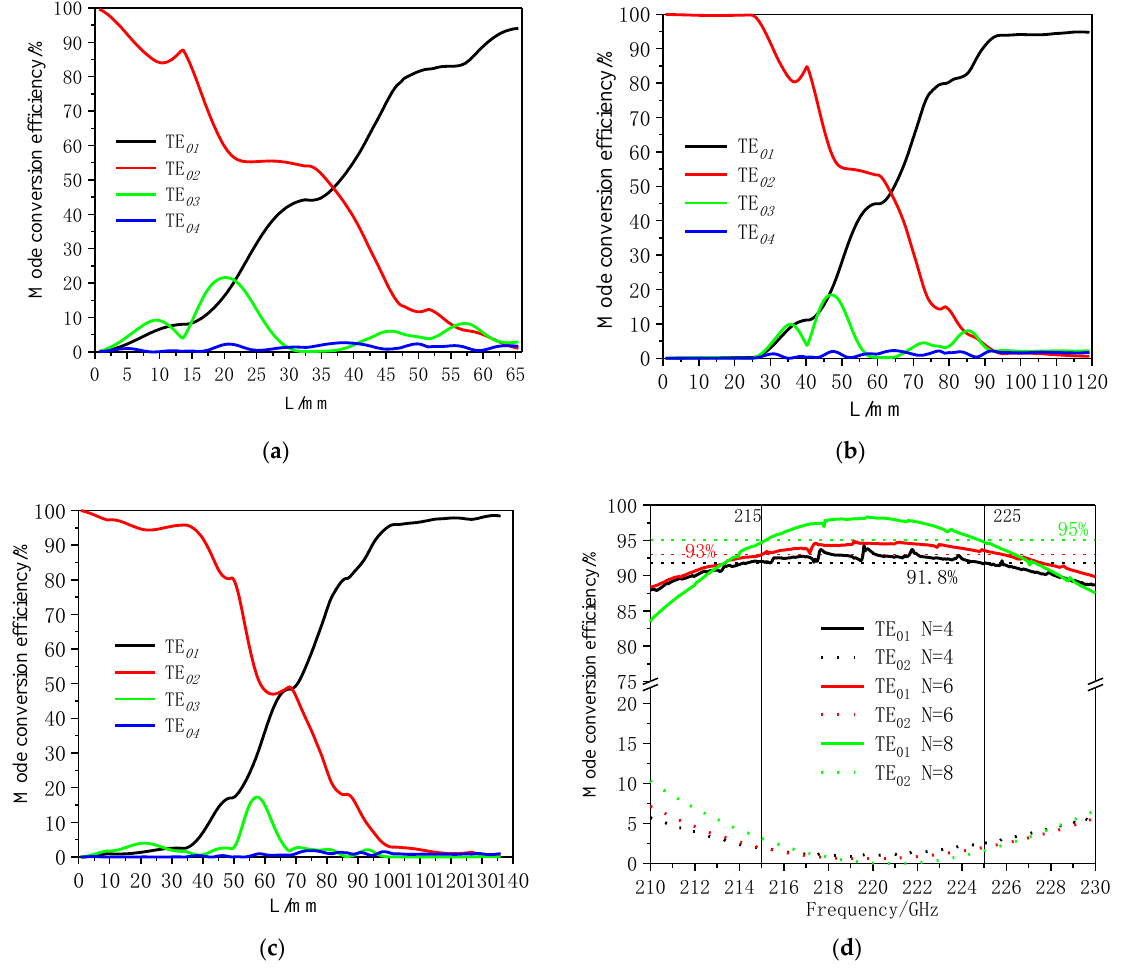
Figure 2. The calculation results of TE 02 -TE 01 mode converter: ( a ) Mode conversion efficiency along z of a 4-segment converter; ( b ) Mode conversion efficiency along z of a 6-segment converter; ( c ) Mode conversion efficiency along z of an 8-segment converter; ( d ) Mode conversion efficiency in the different frequencies.